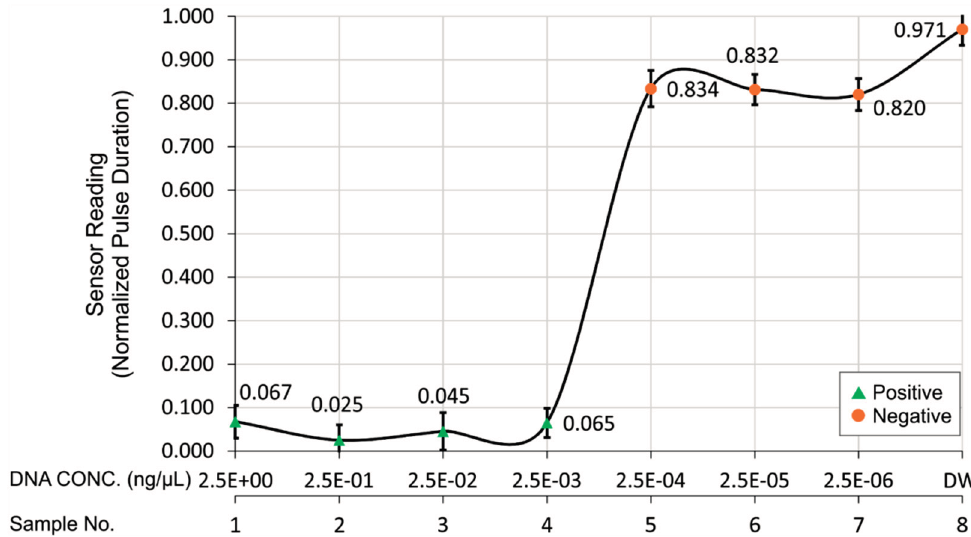
Figure 7. Sensitivity test results of the detection system with different concentrations of Salmonella DNA template. The target is classified as positive when the sensor reading is lower than 0.1 and as negative when the sensor reading is higher than